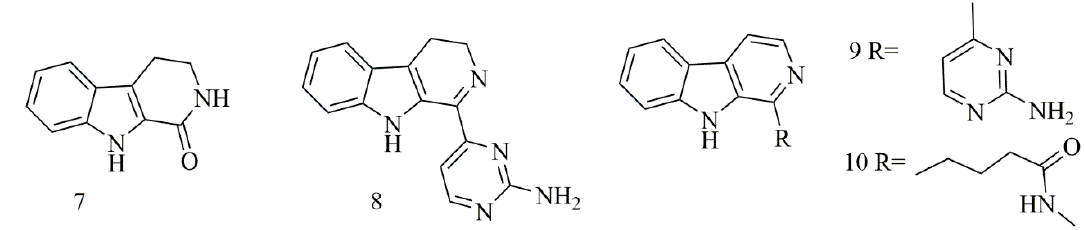
Figure 2. Structures of β -carboline alkaloids isolated from sponges.